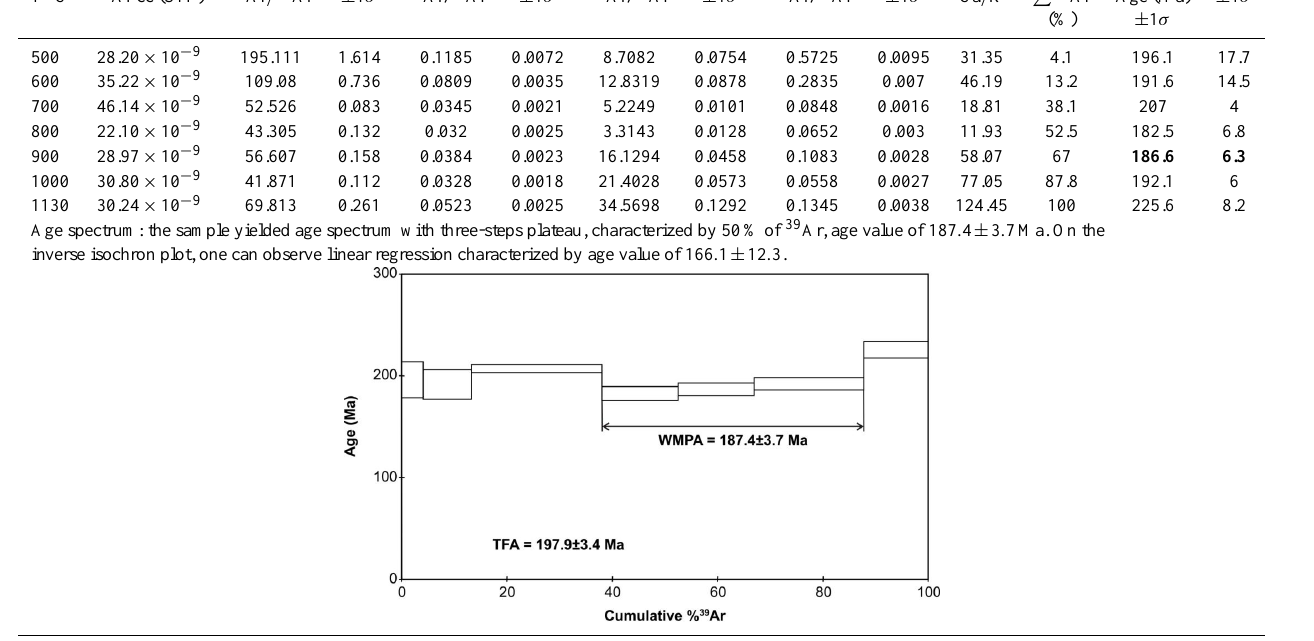
Table 2c. Whole-rock 40 Ar/ 39 Ar age data for an epidote- actinolite schist rock from a metamorphic block in the Ankara Mélange, Turkey. 962 Sample: YK-1: epidote- actinolite schist, J=0.004428±0.000051